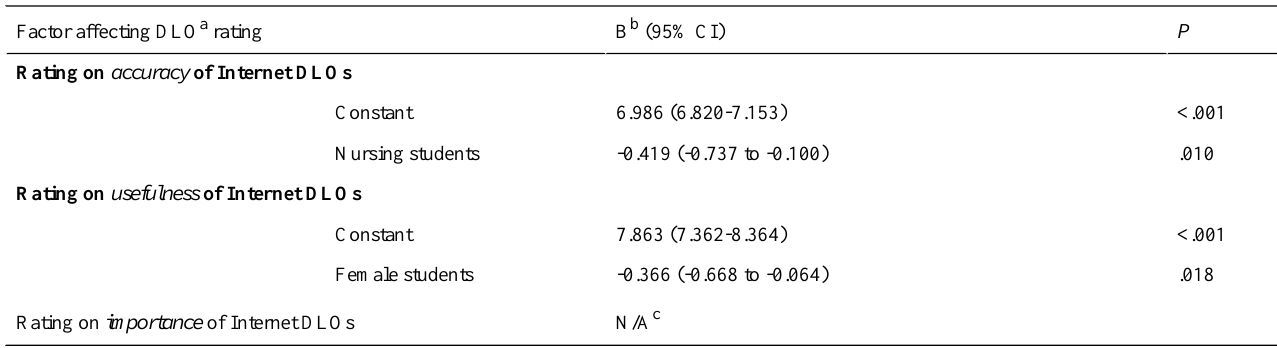
Table 6. Factors affecting rating of Internet digital learning